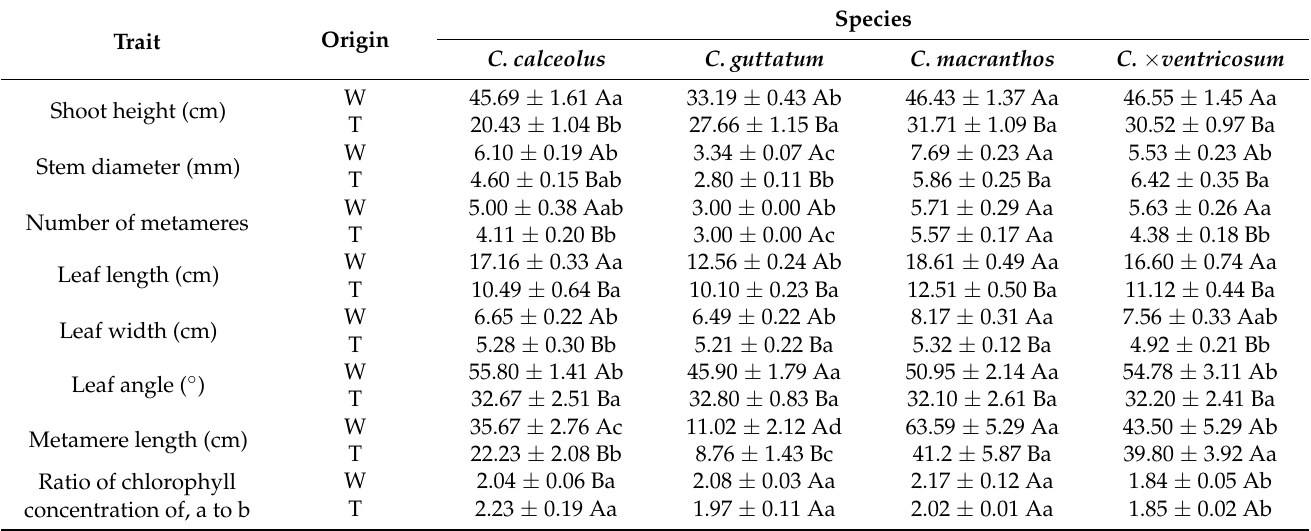
Table 2. Inter- and intraspecific variations in plant growth parameters in four Cypripedium species.